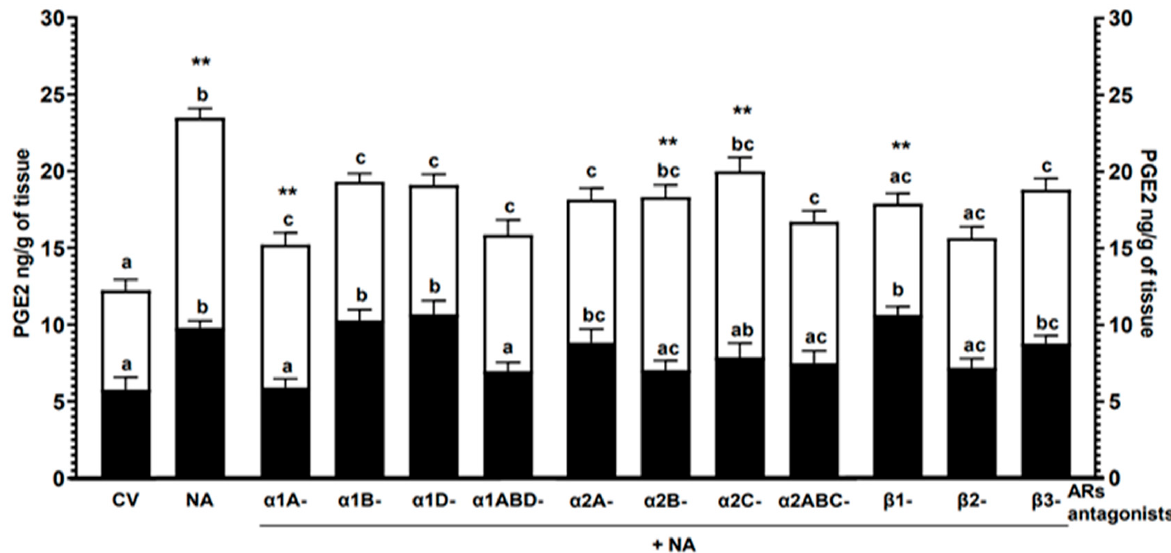
Figure 3. Effects of noradrenaline (NA, 10 − 5 M) alone or antagonists of α 1-, α 2- and β -ARs (10 − 4 M) with noradrenaline on the PGE2 secretion from the pig endometrium of the CON (black bars) and E. coli (white bars) groups, estimated by ELISA. Treatments were performed in triplicate for each of the five gilts in the individual groups. Results are expressed as the mean ± sem. Different letters (a–c) indicate statistical differences ( p < 0.05–0.001) within each group for each subtype of α 1- or α 2-AR antagonists with noradrenaline or class of β -AR antagonists with noradrenaline in relation to the control value (CV, untreated tissue) and noradrenaline action alone; ** indicates statistical difference ( p < 0.01) between groups for the same treatment.